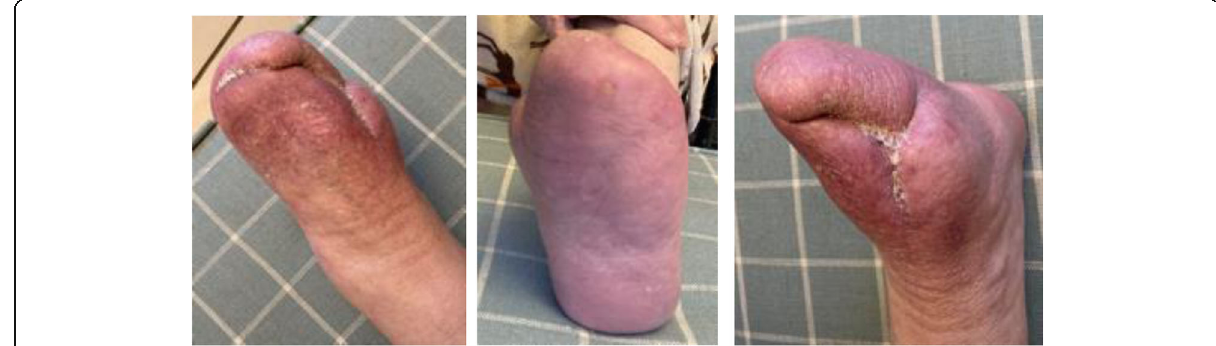
Fig. 3 Most recent images of the foot, 18 months post